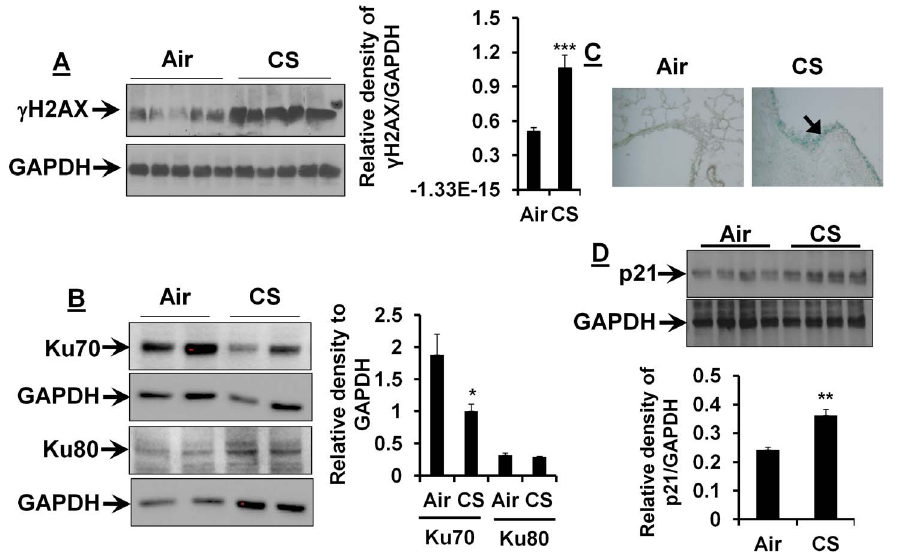
Figure 1. CS exposure induces DNA damage and cellular senescence associated with increased p21 level in mouse lungs. CS increased c H2AX level ( A ), but reduced the levels of Ku70 in mouse lungs ( B ). Both SA- b -gal activity ( C ) and p21 level ( D ) were increased in lungs of CS-exposed mice. Gel pictures shown are representative of at least 3 separate mice. Relative density ratio is indicative of results after normalizing to corresponding GAPDH. Data are shown as mean 6 SEM (n=3 to 6 per group). Original magnification, 6 200. * P , 0.05, ** P , 0.01, *** P , 0.001 vs air- exposed mice.